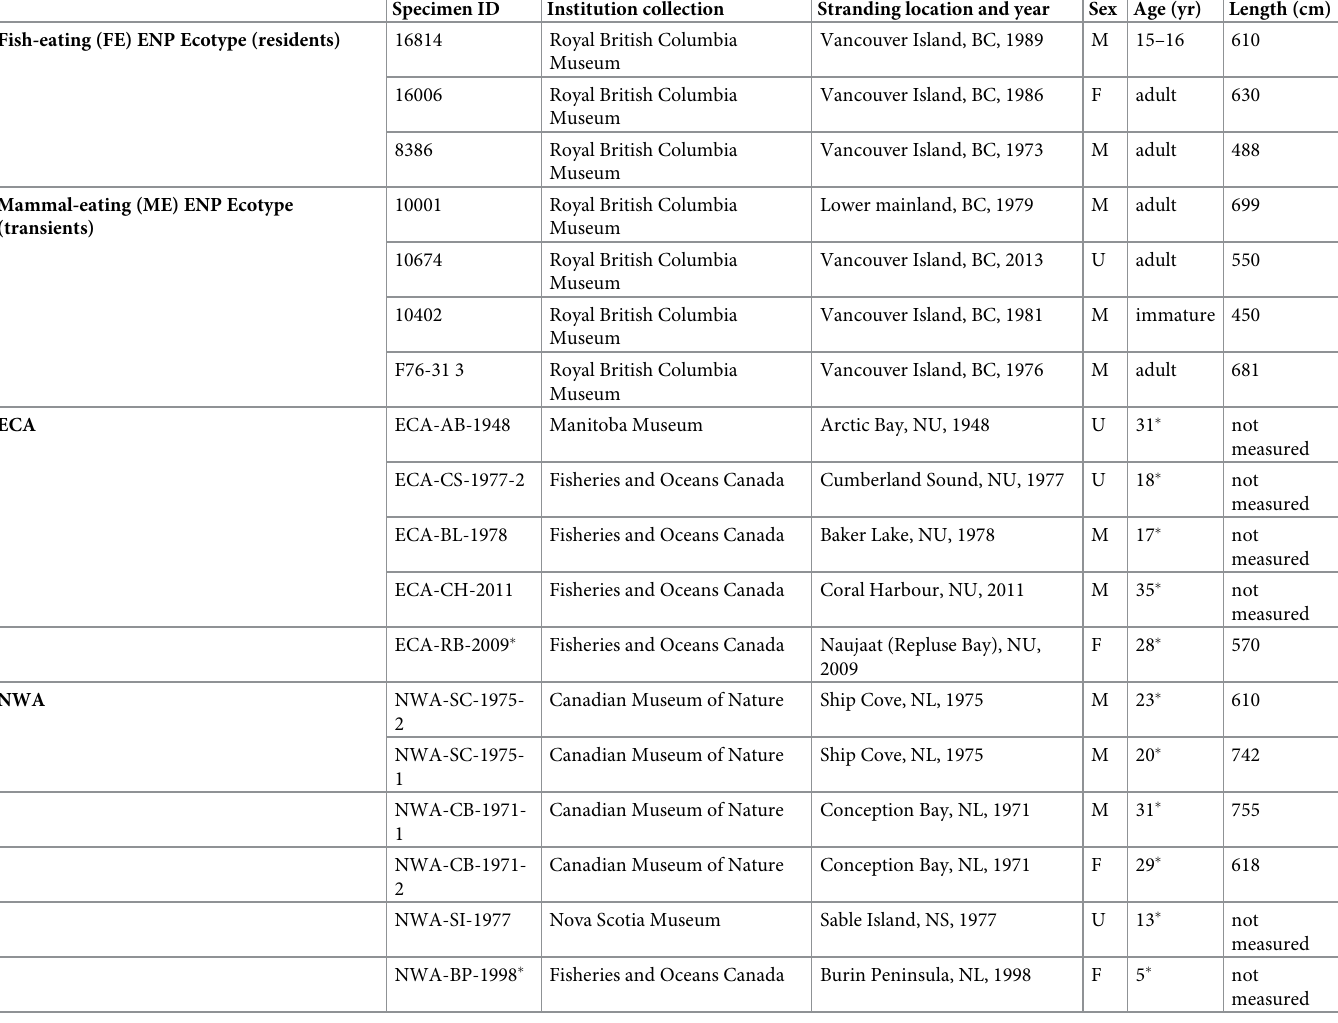
Table 1. Stranding location and other data (estimated age, sex, and body length) of killer whale ( Orcinus orca ) ecotypes from the eastern North Pacific (ENP) and killer whales from the eastern Canadian Arctic (ECA) and Northwest Atlantic (NWA) included in this